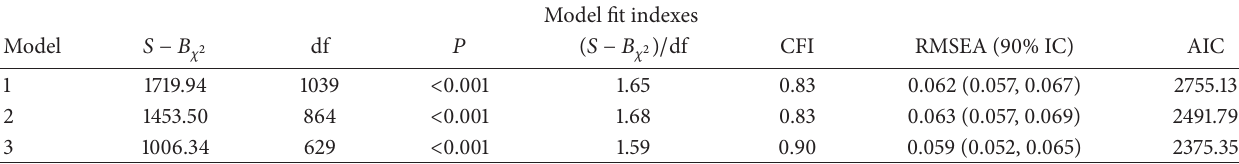
Table 4: Structural equations models and model fit